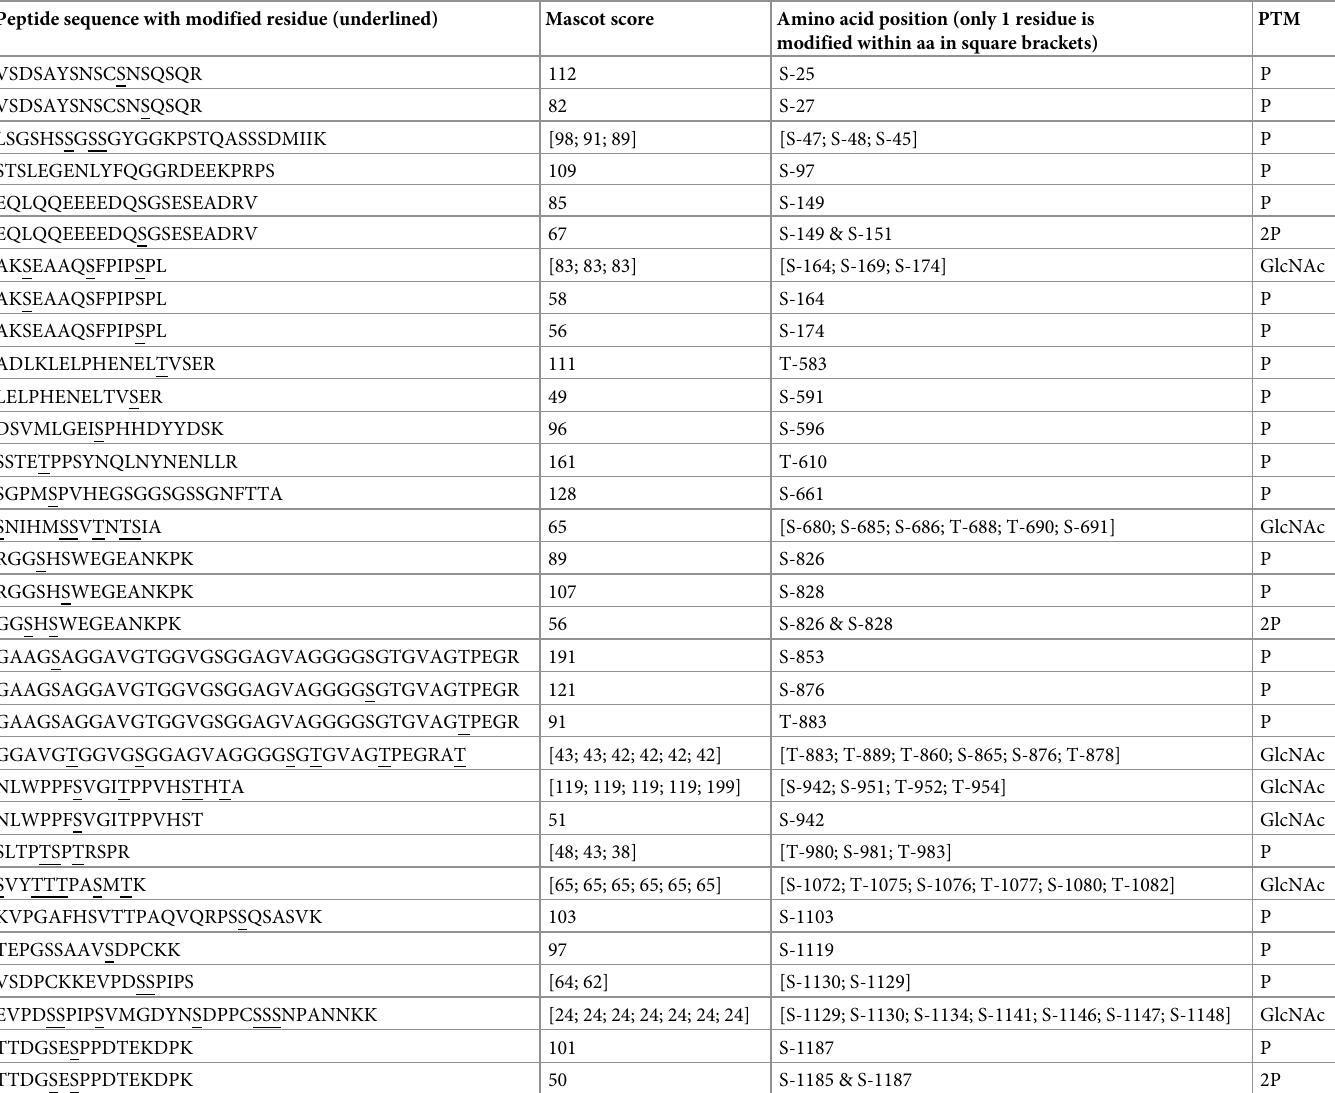
Table 1. Identification of PER O-GlcNAcylation and phosphorylation sites in fly head tissues. Peptide sequence with modified residue